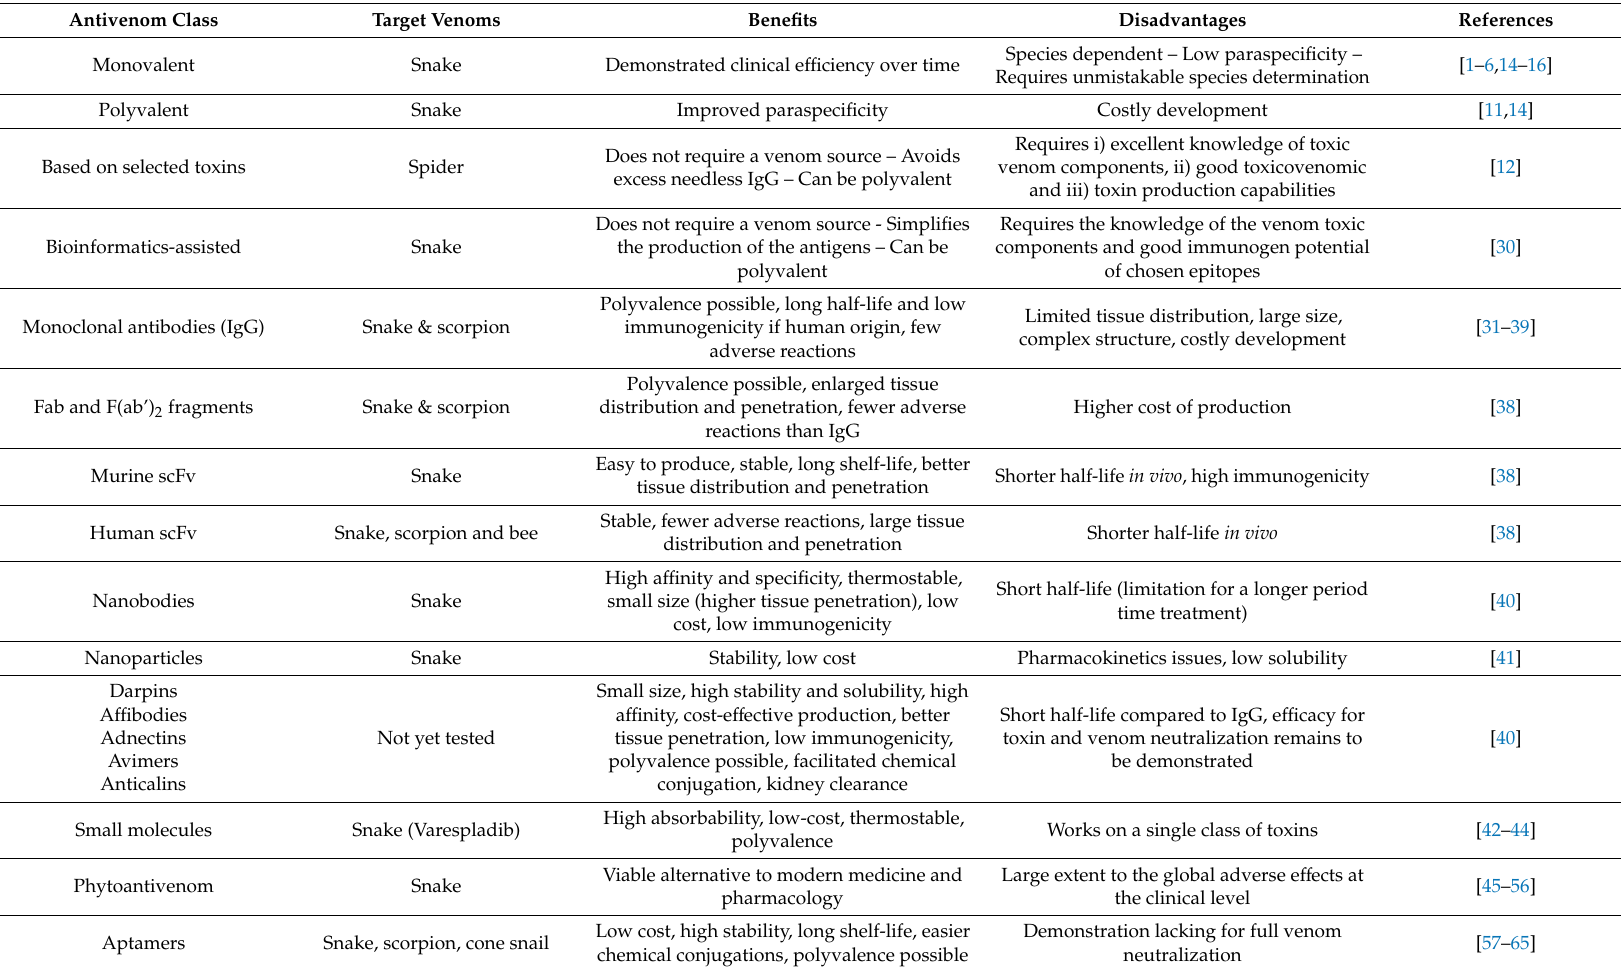
Table 1. Technological initiatives and progresses in the development of antivenoms. IgG: immunoglobulin